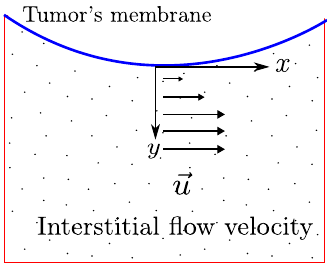
Figure 2. Outline of cells membrane interstitial zone and no-slip boundary conditions